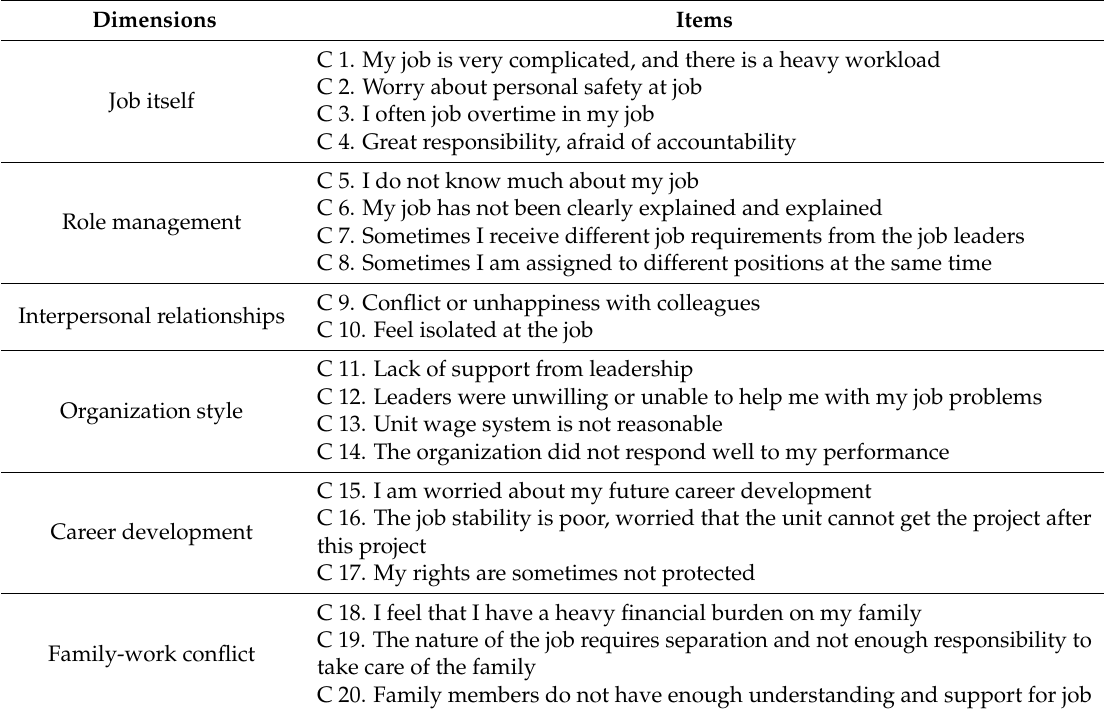
Table 1. Job stress original scale.